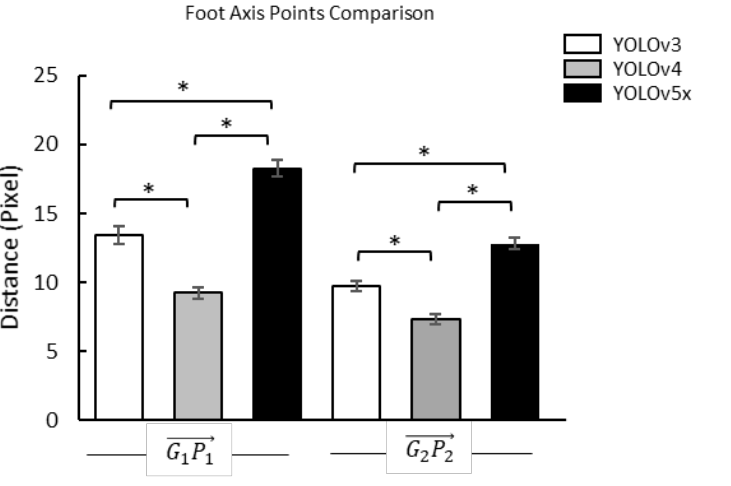
Figure 7. Comparisons of the front ( G 1 P 1 ) and rear of the foot axis point ( G 2 P 2 ) of the angle-box on the distances between ground-truth and prediction points in different YOLO models. G 1 P 1 , the distance between the front points of the ground-truth ( G 1 ) and YOLO model prediction ( P 1 ); G 2 P 2 , the distance between the rear points of the ground-truth ( G 2 ) and YOLO model prediction ( P 2 ); *, a significant difference ( p < 0.01). Table 4. Effect of different points of FPA on the distance between the ground-truth point and pre- diction point.